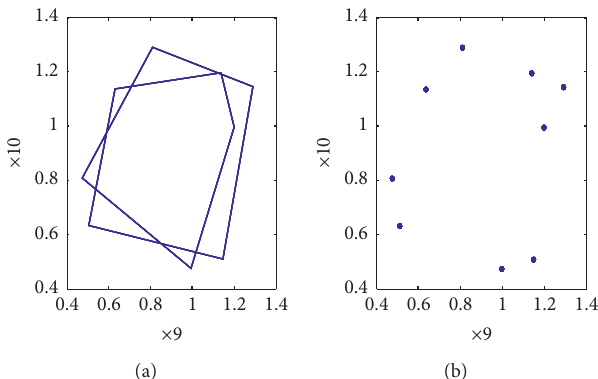
Figure 9: ω � 200 without random perturbation. (a) Phase trajectories. (b) Poincare maps.